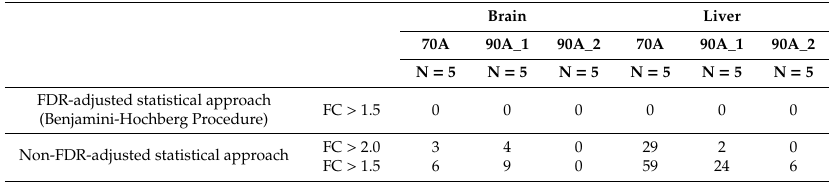
Table 1. Di ff erentially expressed transcripts in the brain and liver between IF-MF- and sham-exposed mice after FDR- and non-FDR-adjusted approaches. Brain Liver 70A FDR-adjusted statistical approach > 1.5 0 0 (Benjamini-Hochberg Procedure) FC Non-FDR-adjusted statistical approach